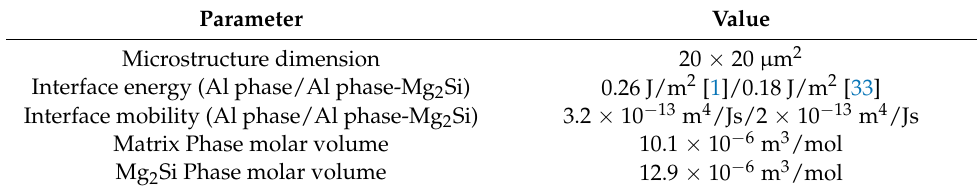
Table 4. Principal parameters of ageing